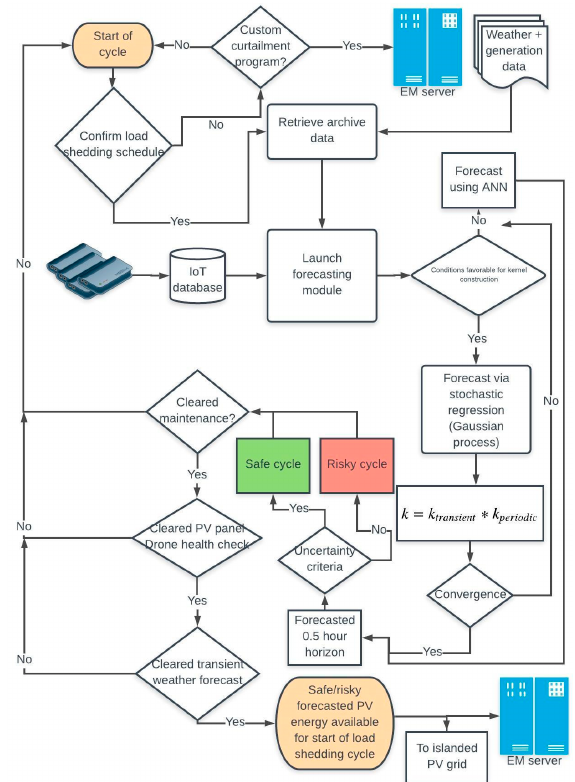
Figure 1. Optimization scheme for the determination of the available PV power output for a 0.5 h horizon. The PV scheme feeds both load and diesel generator schemes.